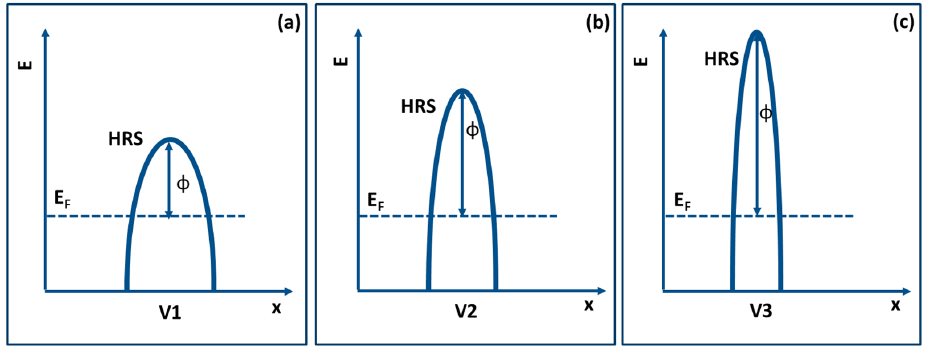
Figure 10. Experimental I–V characteristics (symbols) associated with the mean HRS currents extracted from DC reset operations of V1, V2 and V3 memristive devices. The solid lines are simulated characteristics using the QPC model for HRS (Equation (2)).